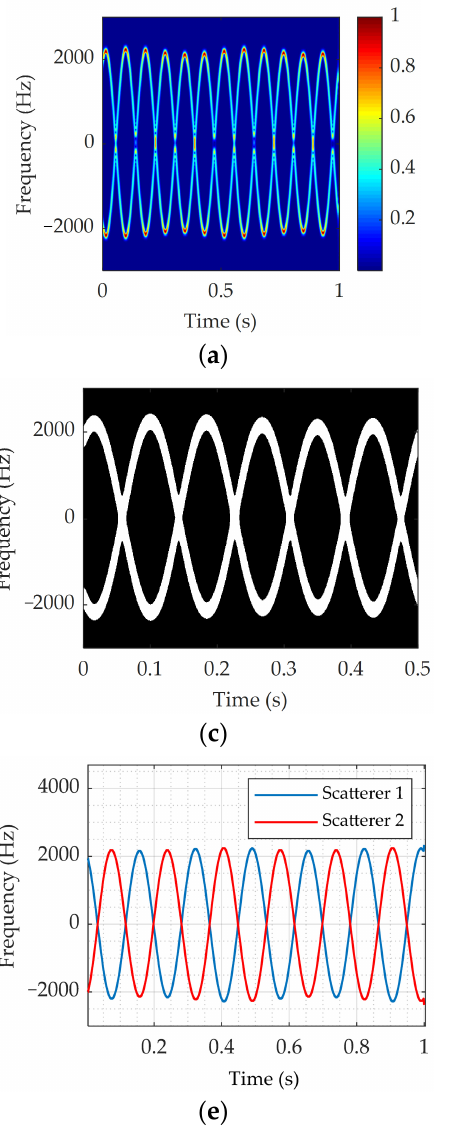
Figure 5. The micro-Doppler effect of the rotating antenna. The echo micro-Doppler curves ( a ); The Gaussian mask results ( b ); The binarization results ( c ); The skeleton extraction results ( d ); The micro-Doppler curve separation results ( e ). Table 2. The decomposition results of the OMP